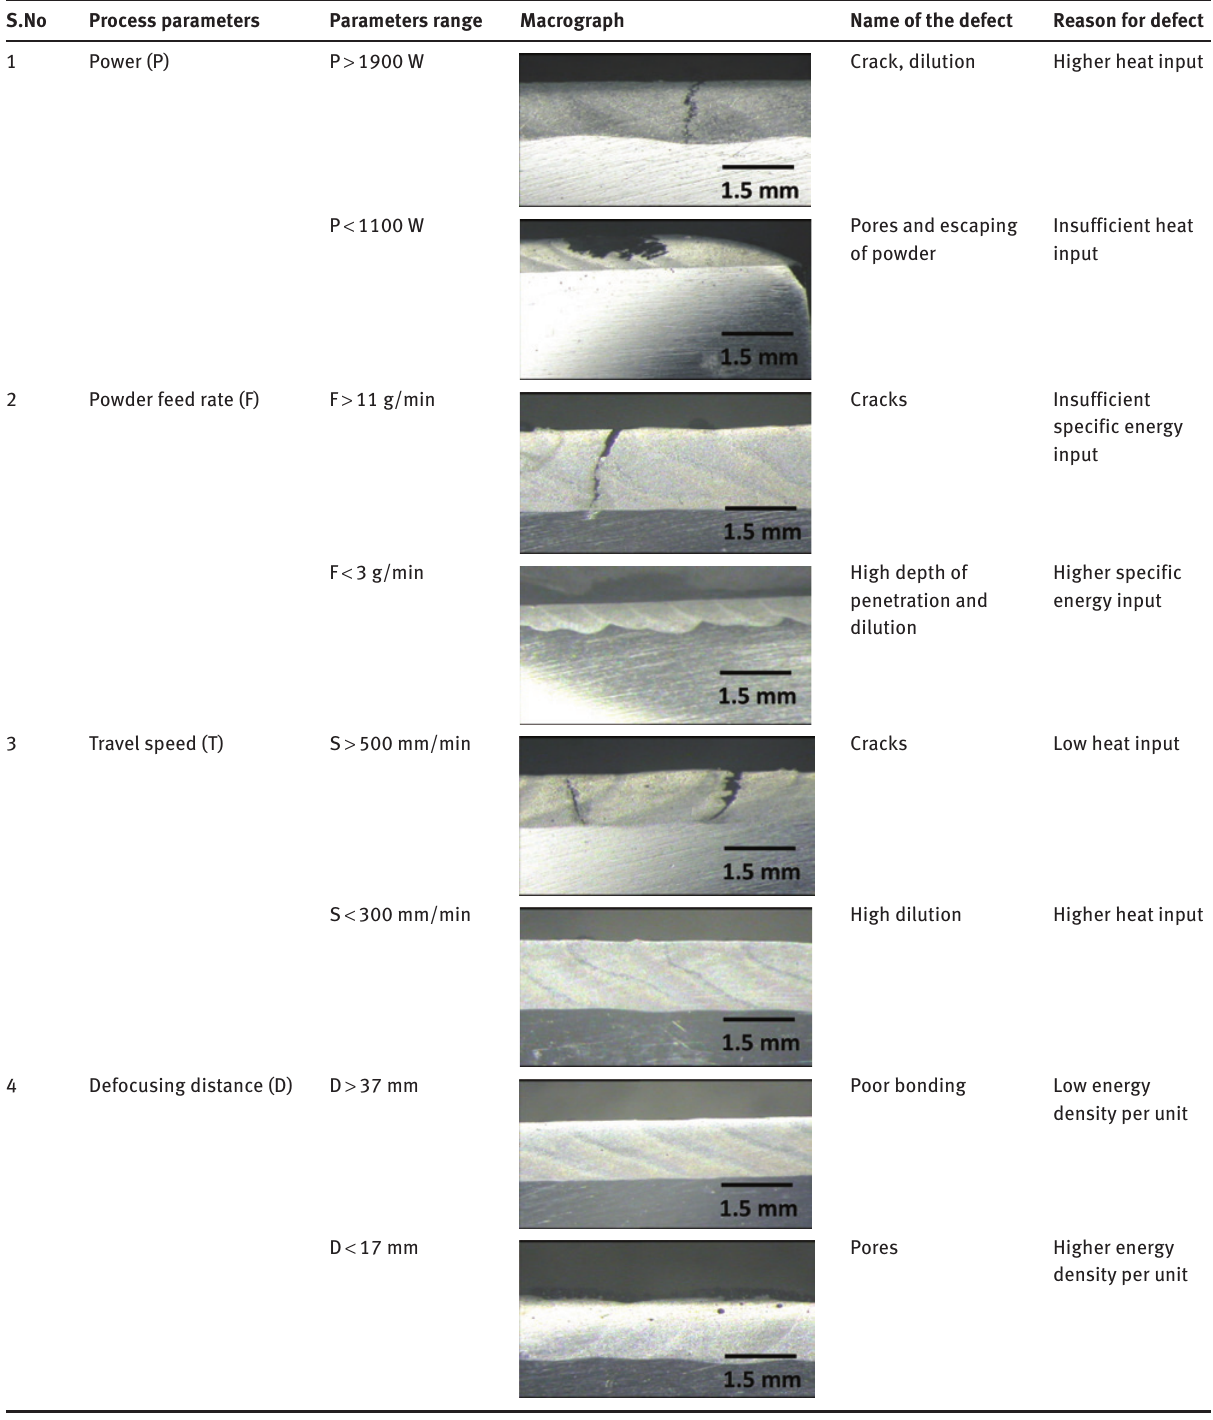
Table 4: Macrostructure analysis for fixing the working range of laser hardfacing.